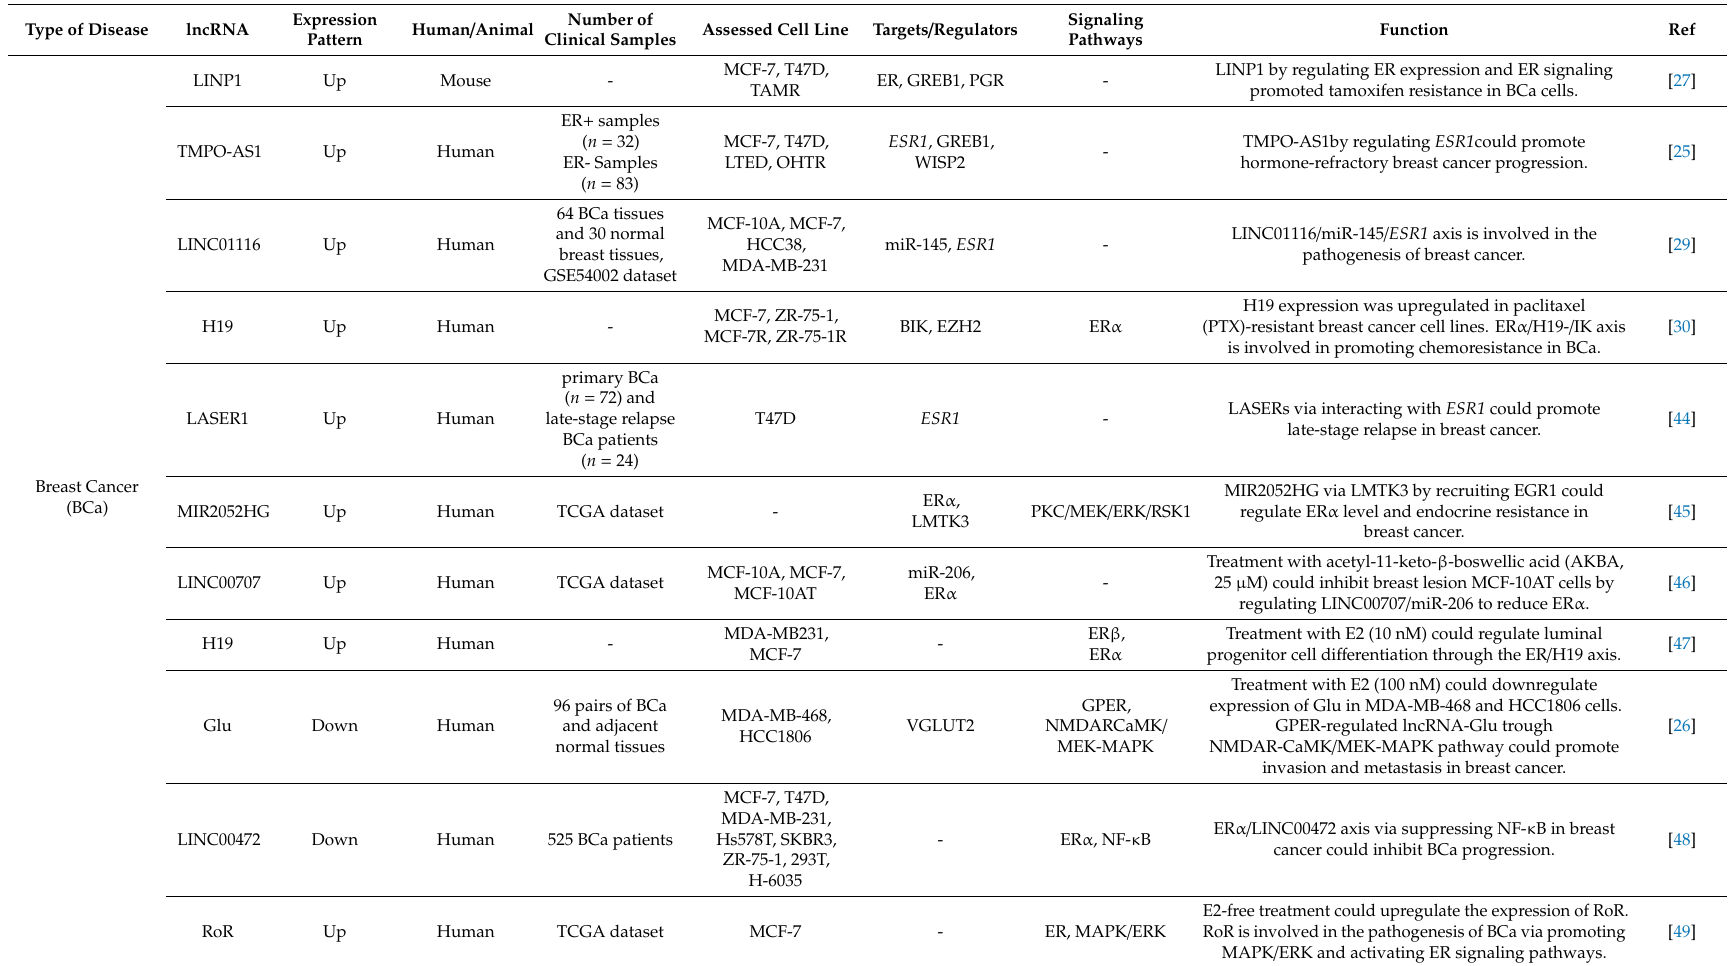
Table 1. List of dysregulated ER-associated lncRNAs and their functions in